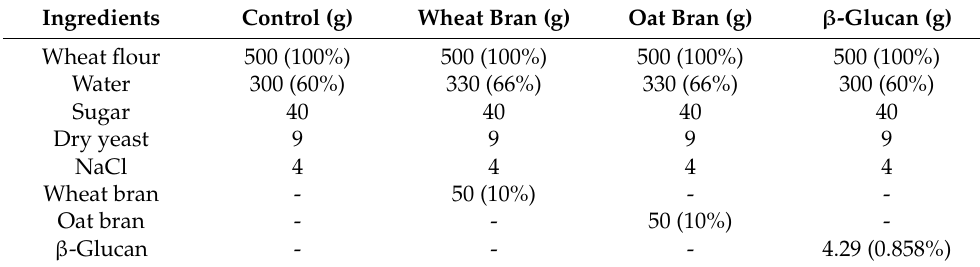
Table 1. Ingredients in the test